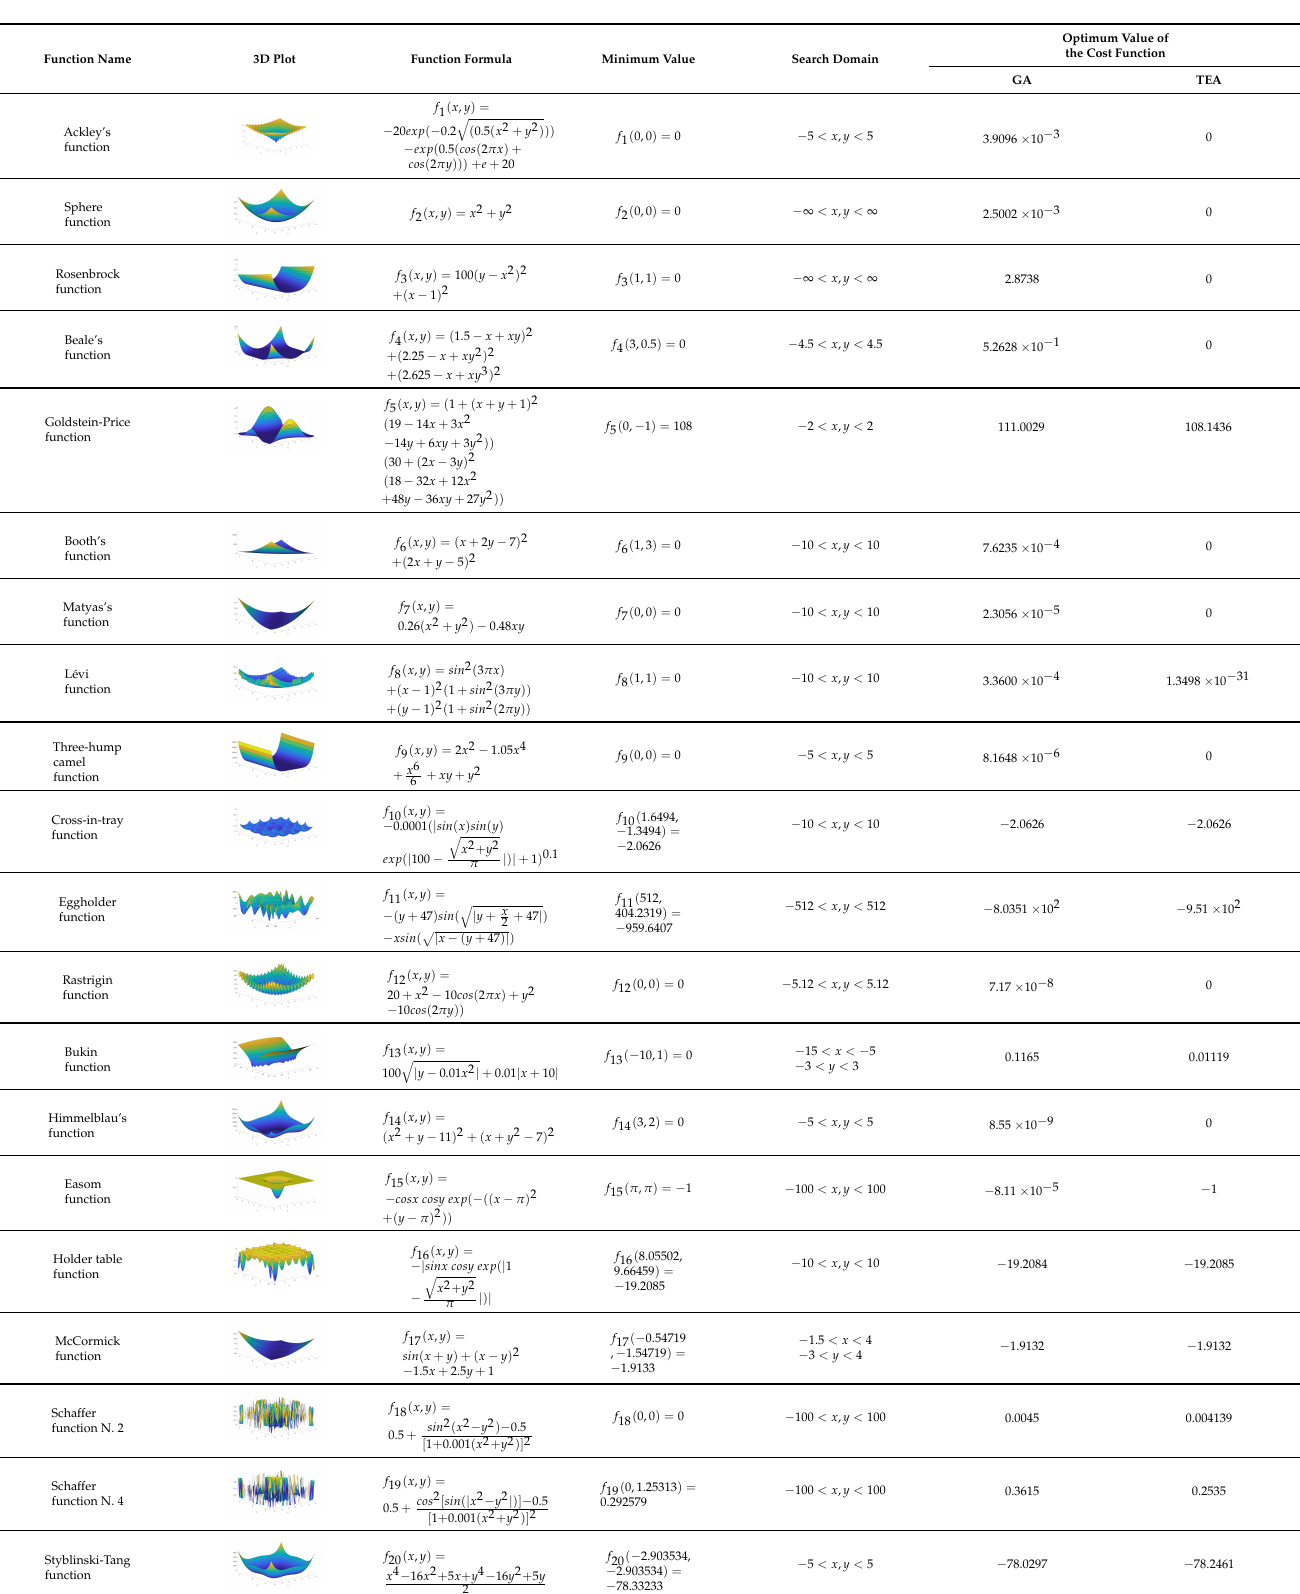
Table 1. Details of the functions